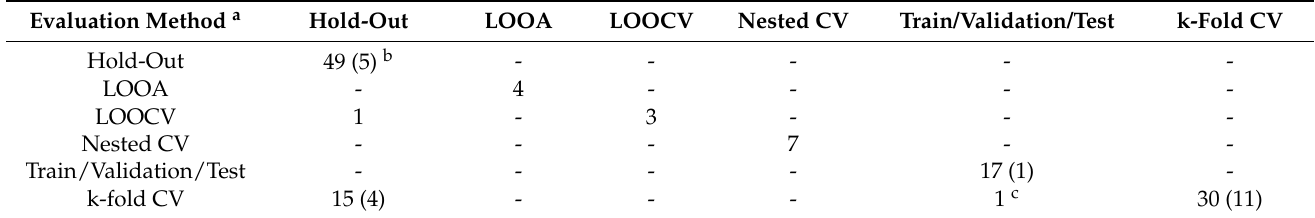
Table 2. Number of studies employing each evaluation method(s) (n = 127).